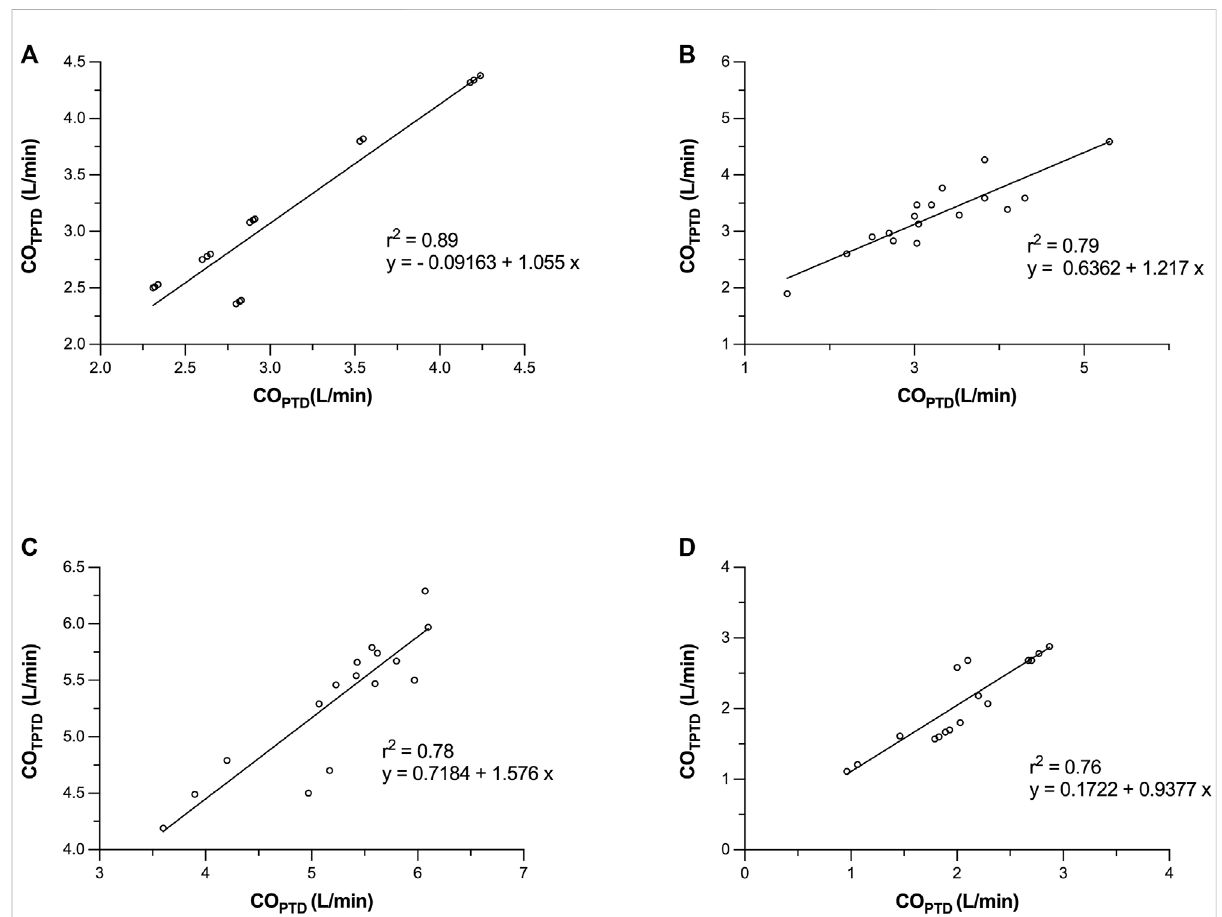
FIGURE 3 Bland – Altman representation depicting the agreement between the cardiac output (CO) measurements obtained by transpulmonary thermodilution(CO TPTD )andintermittentpulmonaryarterythermodilution(CO PTD )infourconsecutivemomentsofthestudy:beforestartingtheleft ventricular assist devices (LVADs) (A) , with the LVAD started in normovolemia (B) , hypervolemia ( fl uid overloading) (C) , and hypovolemia (shock hemorrhage) (D)